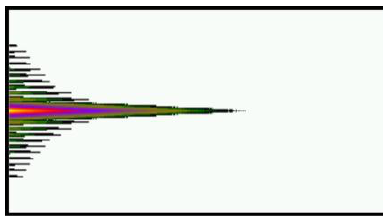
Figure 22. The 2D and 3D power plot of the cladding mode ( ν = 21).